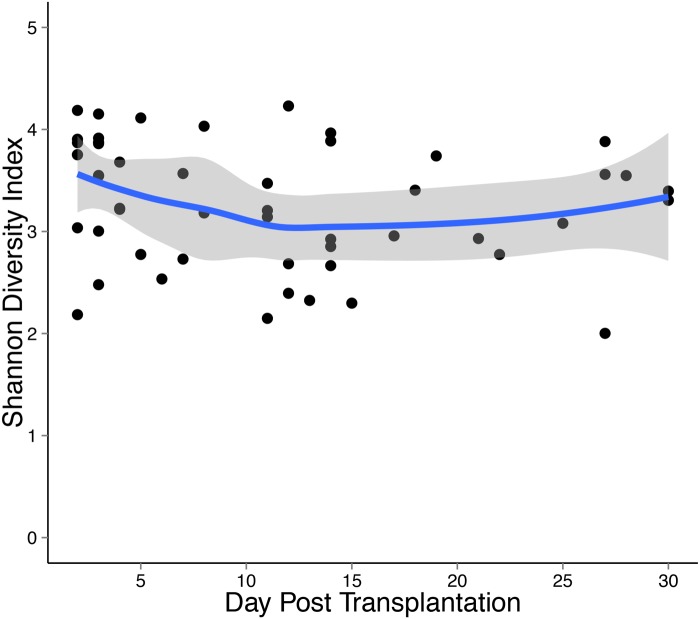
Gut Microbial Diversity During the First Month of Kidney Transplantation.Shannon diversity index is represented over time in all 19 kidney transplant recipients. On the x-axis is the day after kidney transplantation and on the y axis is the Shannon diversity index. Each individual black circle represents a fecal specimen at the time point indicated on the x-axis. The blue line represents a locally estimated scatterplot-smoothed (LOESS) calibration curve with the grey areas representing 95% confidence intervals. As shown, the Shannon diversity index was relatively stable in the study cohort during the first month of transplantation.